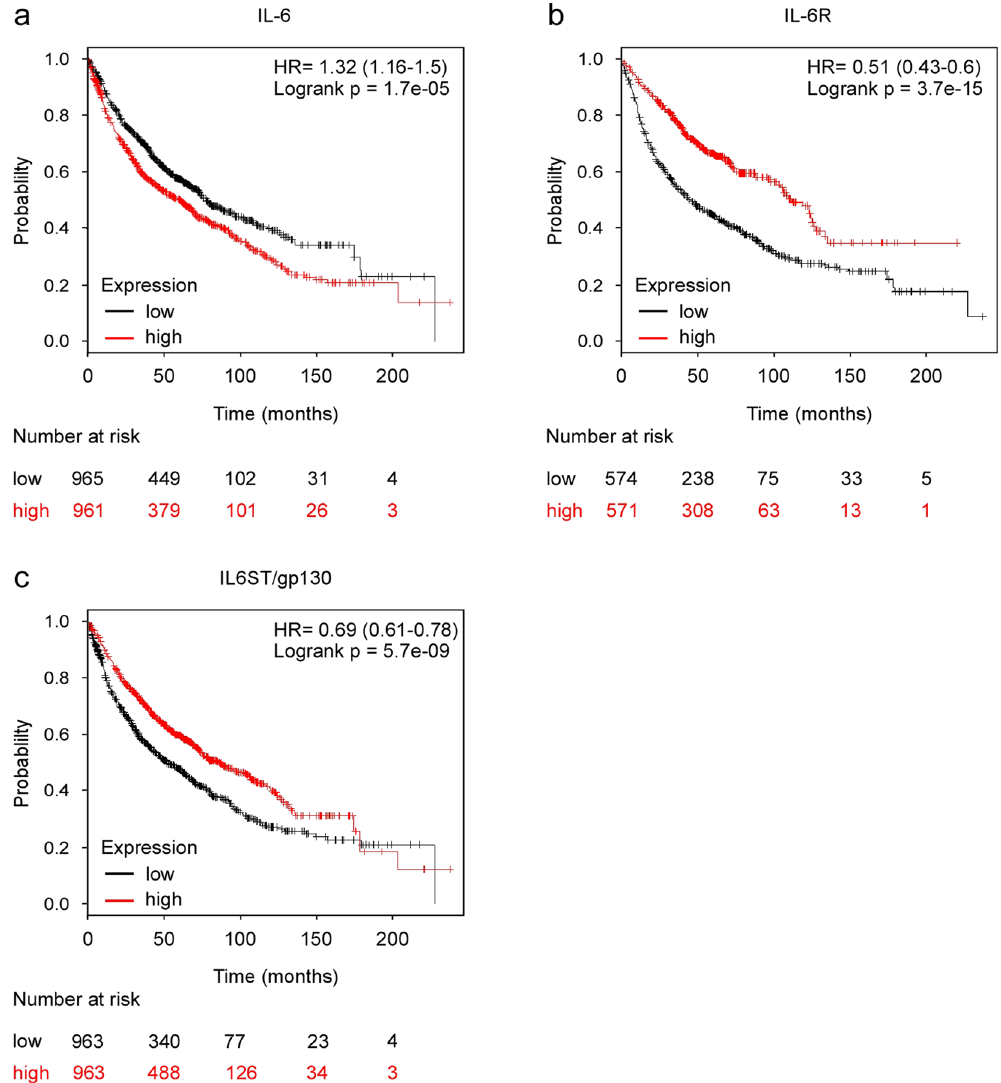
Figure 6. High expression of IL-6 mRNA in tumor tissue predicts poor prognosis of lung cancer patients. ( a ) High expression of IL-6 in the tumor predicts a worse overall survival of lung cancer patients. ( b , c ) High expression of IL-6 receptor and IL6ST/gp130, respectively, in the tumor predict prolonged survival of lung cancer patients. HR = hazard ratio. The data are obtained using the kmplot.com database tool 27, 28